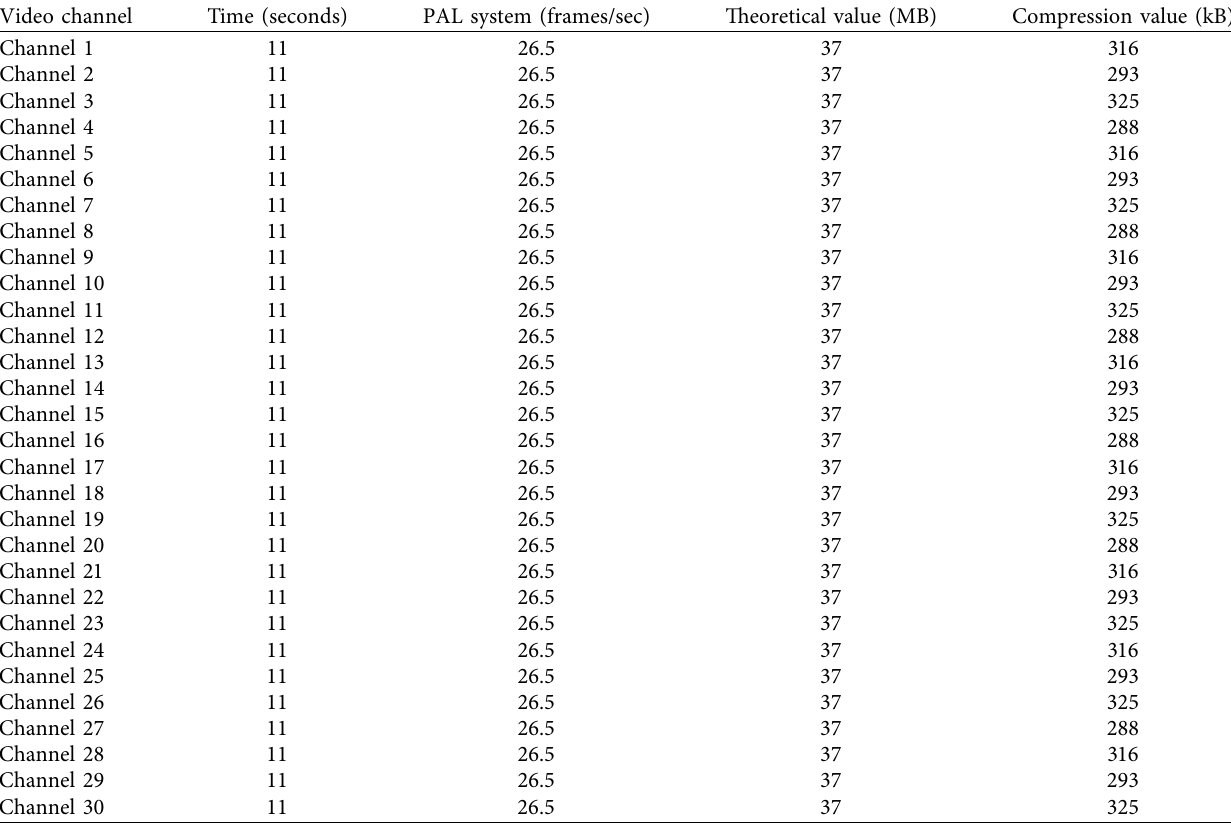
Table 1: System channel H.264 encoding